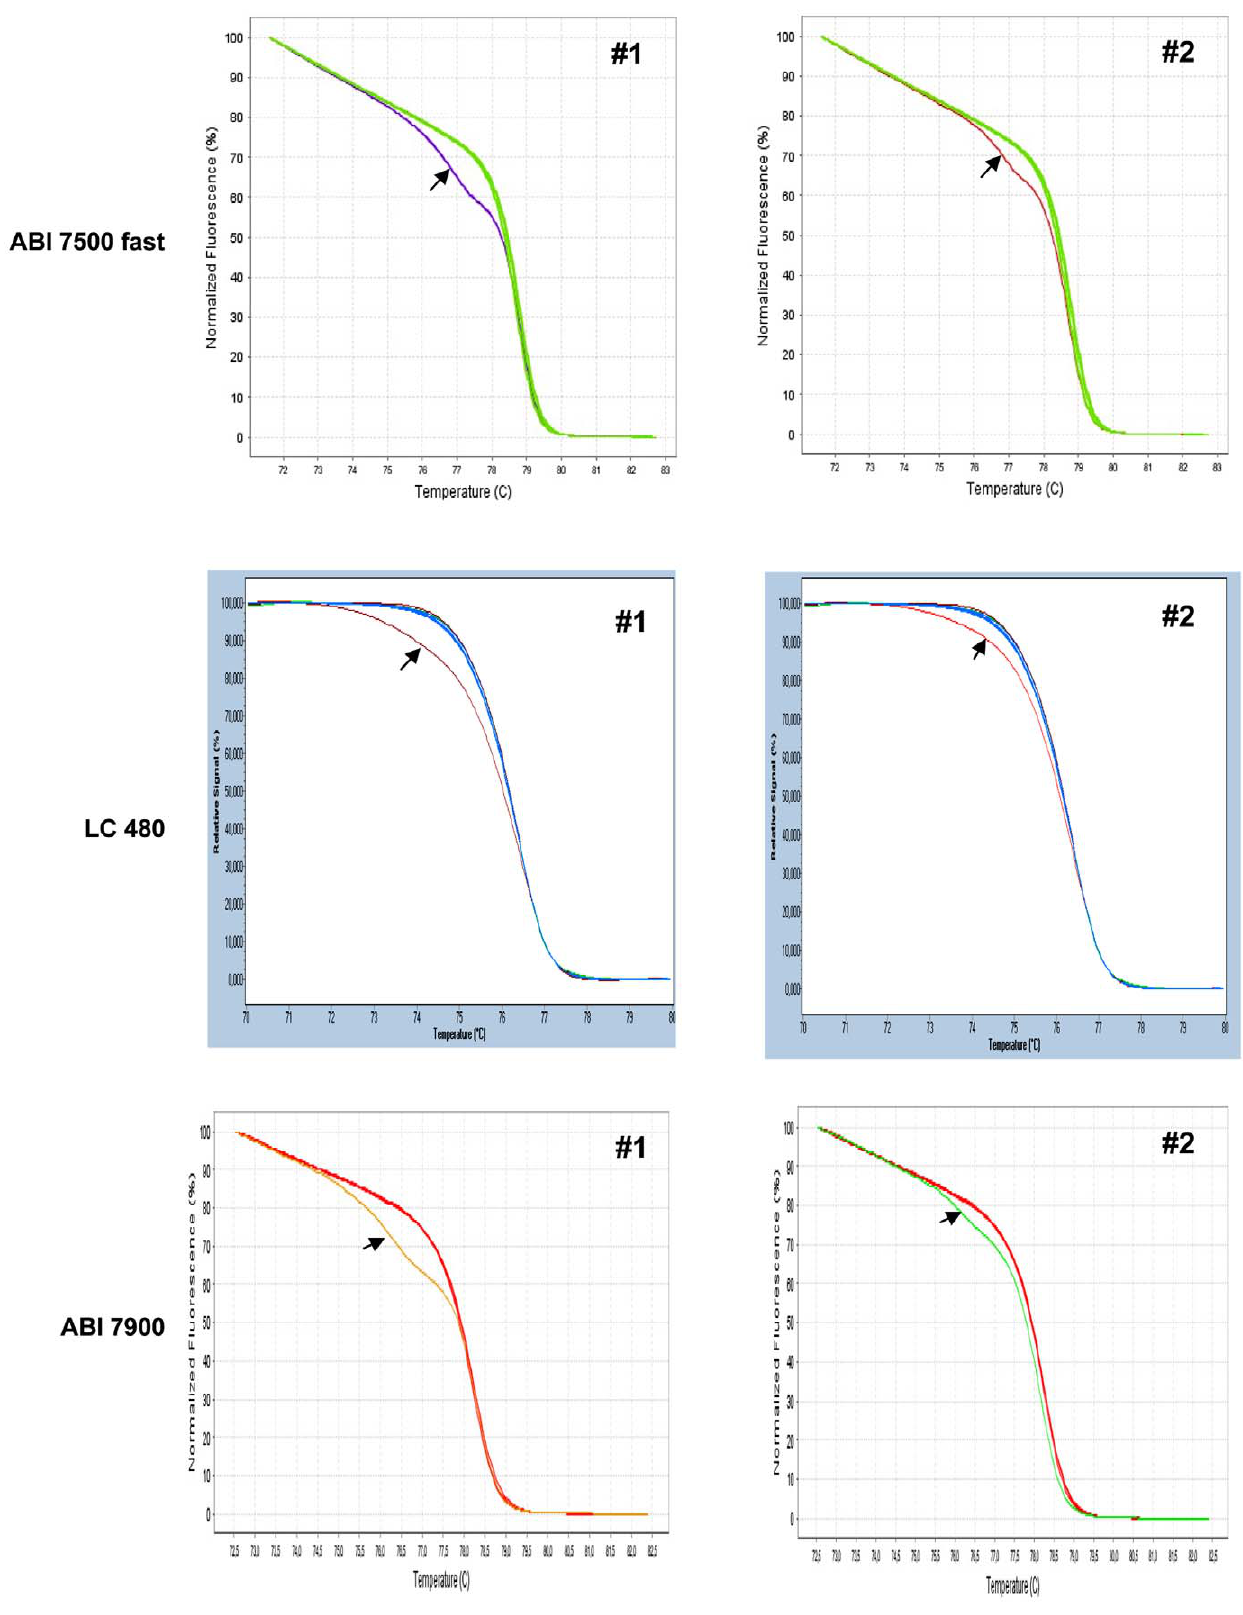
Figure 3. HRM profiles on 3 different instruments for 2 patients. Total blood DNA from 2 patients was analysed on 3 different instruments together with non mutated DNA. Arrows show mutant DNA.